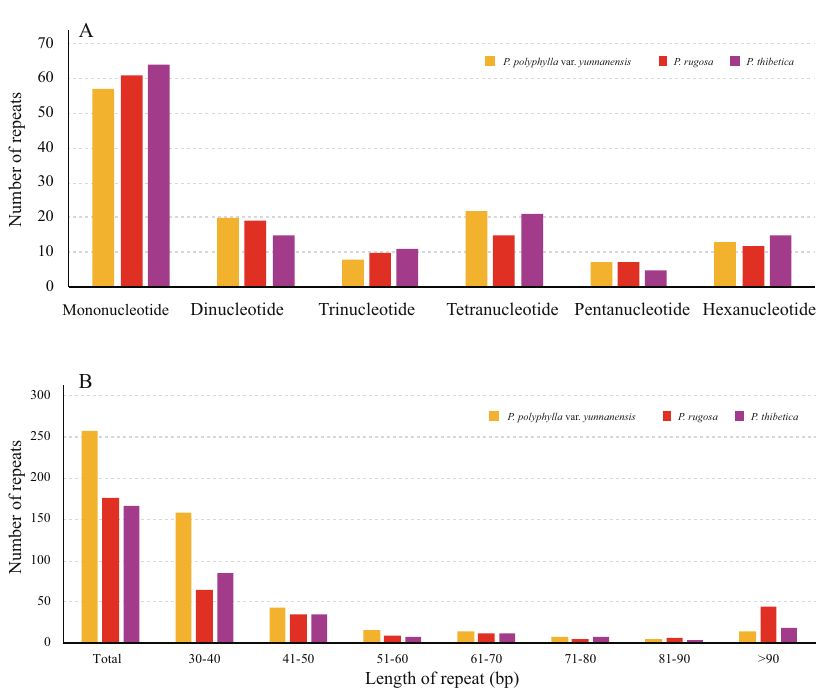
Figure 2. Analysis of repeated sequences in the three Paris chloroplast genomes. ( A ) Frequency of simple sequence repeats (SSRs) by MISA. ( B ) Frequency of repeat sequences determined by